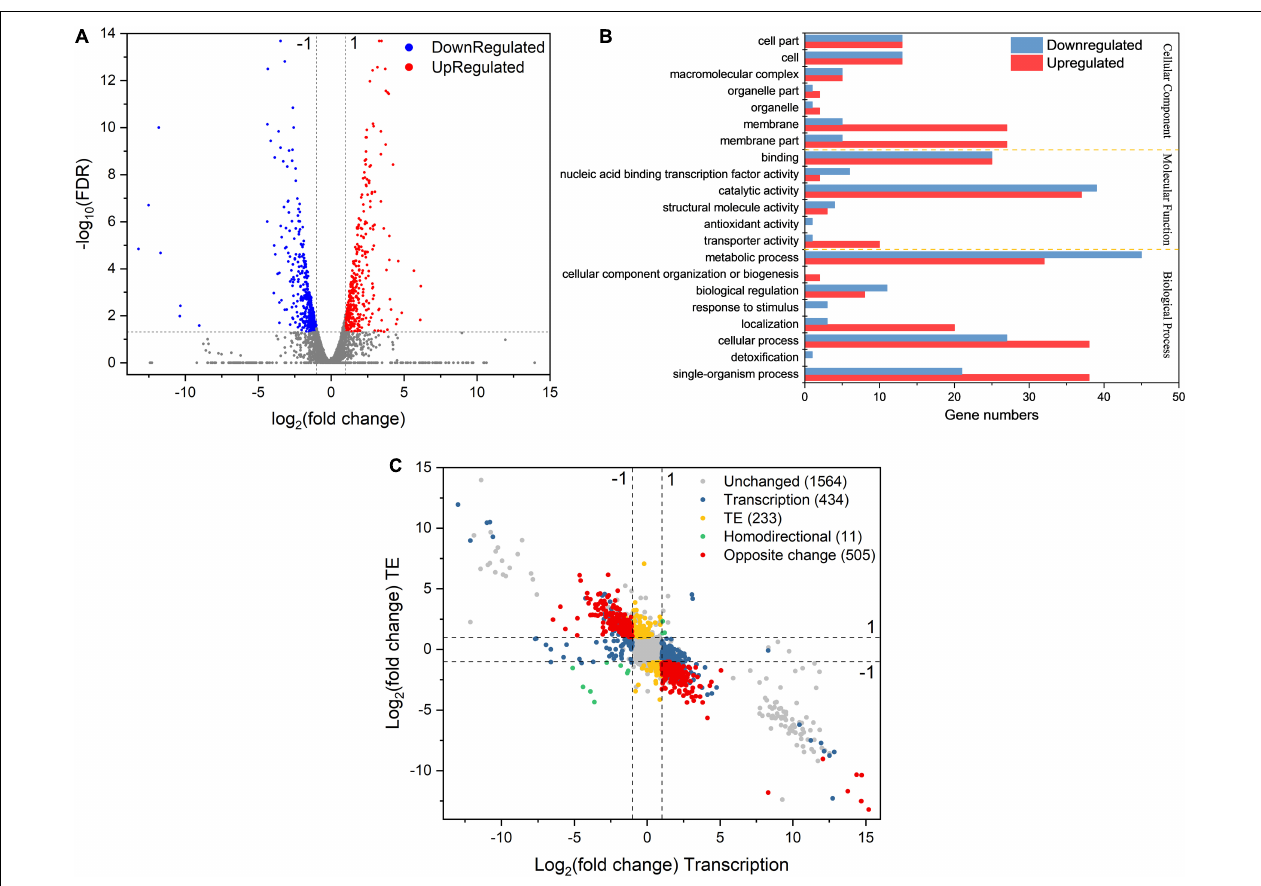
FIGURE 5 | (A) The volcano plot of DEGs’ TE response under osmotic stress. (B) GO annotation of differentially expressed genes with largely changed translation efficiency under sodium lactate stress. (C) Simultaneous monitoring of the distribution of log 2 fold change TE and corresponding log 2 fold change mRNA abundance in L. rhamnosus ATCC 53103 under osmotic stress. The four dash lines indicate log 2 fold change values –1 or +